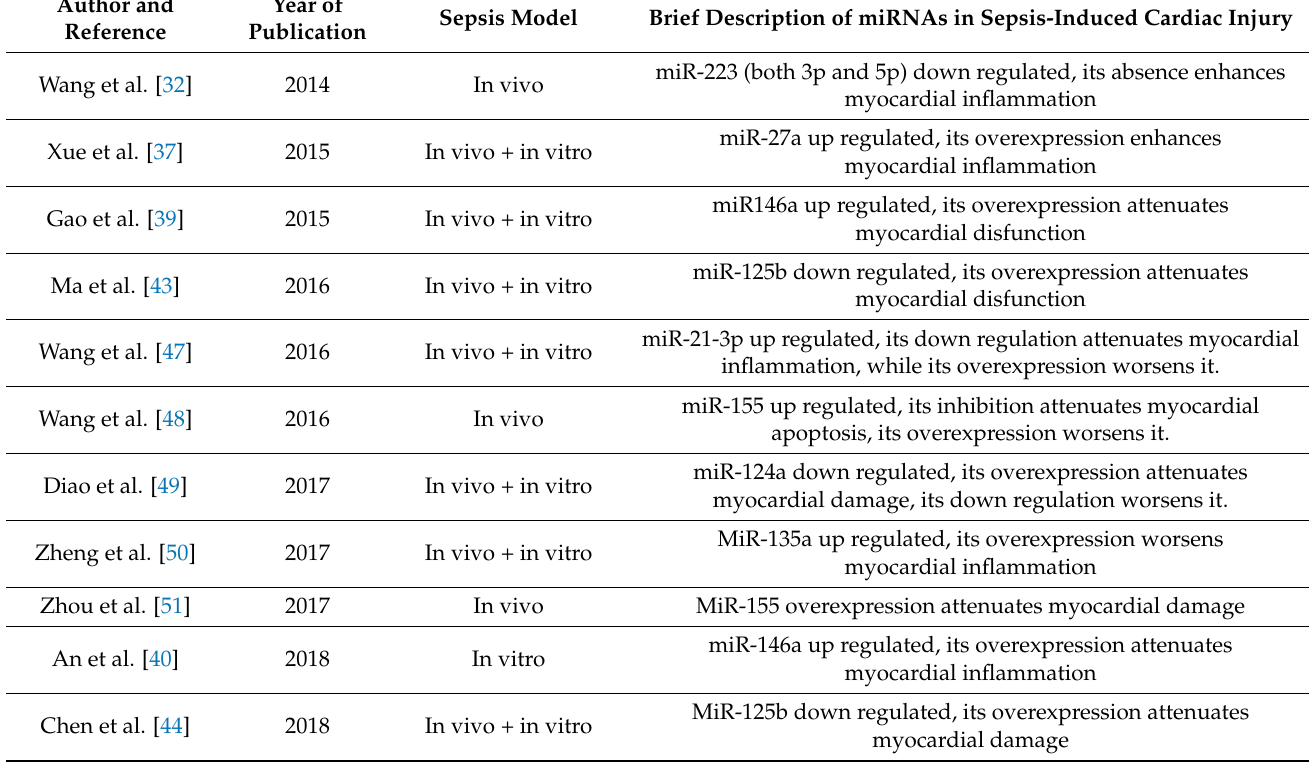
Table 1. Review of the literature on miRNA and cardiac dysfunction in sepsis. MiR indicates